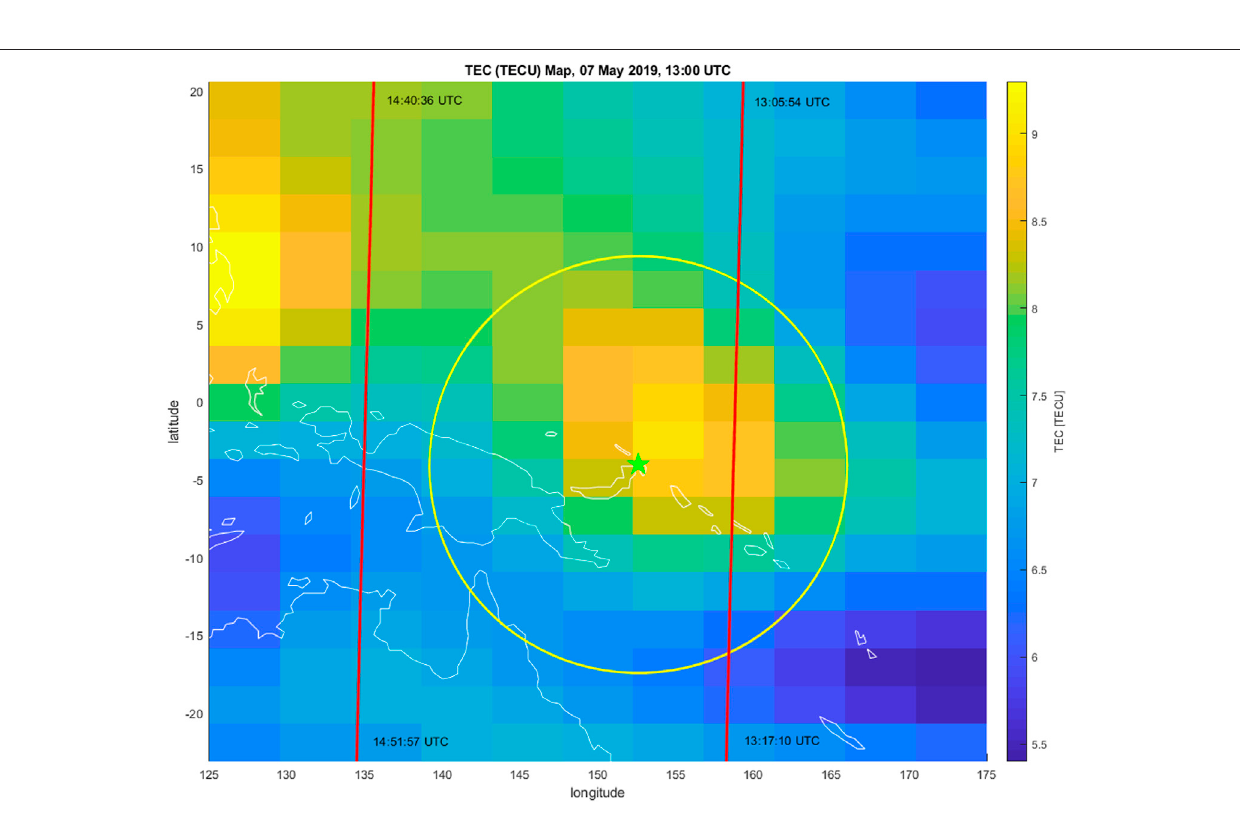
FIGURE 14 | TEC map around the M7.6 Papua New Guinea (May 14, 2019) earthquake on May 7, 2019 at 13:00 UTC. The epicenter is represented as a green star; its Dobrovolsky area is shown by a yellow circle. The red lines represent the Swarm Bravo projection of the track in the same area and time.